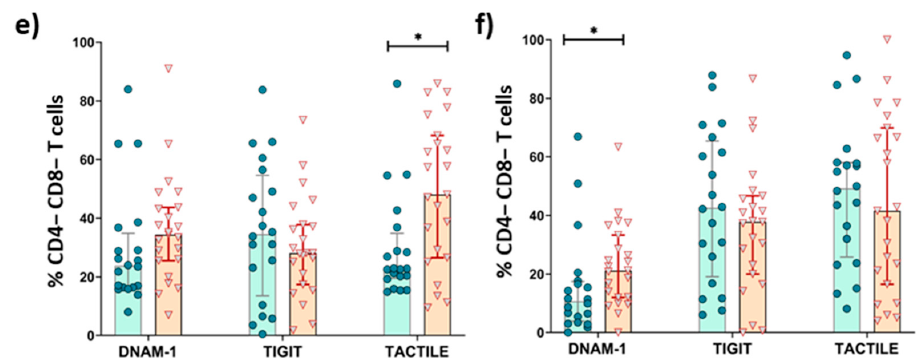
Figure 4. Expression of DNAM-1, TACTILE and TIGIT in T cells subsets from AML patients and healthy donors. The percentages of CD4 + ( a , b ), CD8 + ( c , d ) and CD4 − CD8 − ( e , f ) T cells expressing DNAM-1, TACTILE and TIGIT were analyzed in conventional CD56 − conventional T cells ( a , c , e ) and CD56 + NKT-like cells ( b , d , f ) in AML patients ( n = 23) and HD ( n = 20). Vertical lines indicate interquartile ranges, from the 25th to the 75th percentile. The horizontal lines represent the median values. * p < 0.05, ** p < 0.01, *** p < 0.001. HD: healthy donors, AML: acute myeloid leukemia.